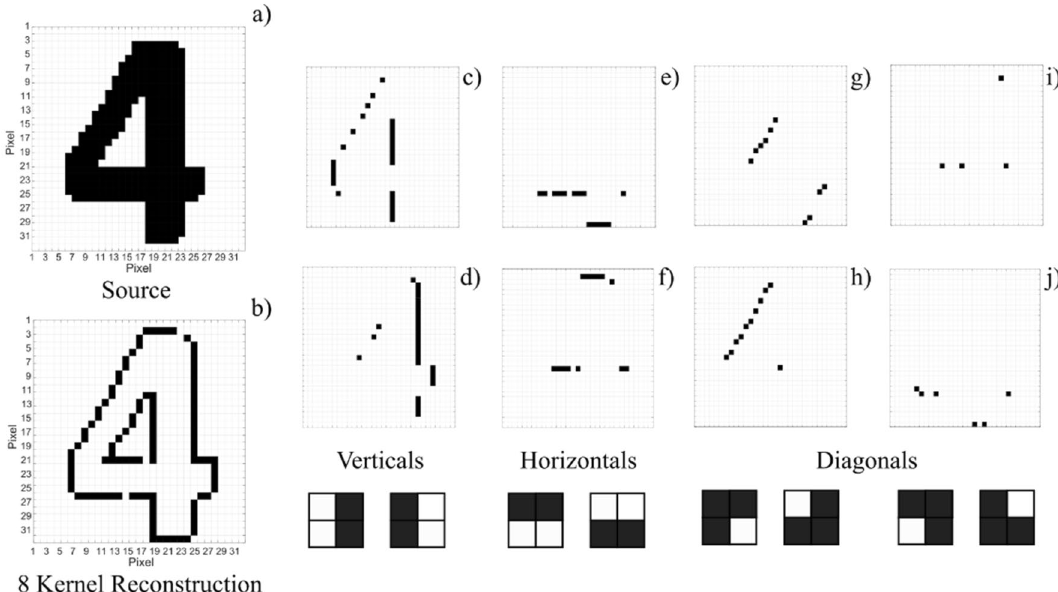
Figure 2. Spike edge-feature detection of a black-and-white image with a VCSEL neuron. The 32 × 32 pixel source image (a) and reconstructed image (b) of a printed “Digit 4” after it’s operated on by eight different 2 × 2 kernels. Plots (c) – (j) depict individual results achieved for each of the 8 2 × 2 kernel operators utilised. These are shown in the insets below plots (c–j) and are respectively: two vertical (c,d) , two horizontal (e,f) , and four diagonal (g–j) kernel operators. Each black dot in plots (b–j ) corresponds to a 100 ps-long long spike fired by the VCSEL neuron upon recognising a specific feature in the source image. The final 8 kernel reconstruction reveals all edges in the image.